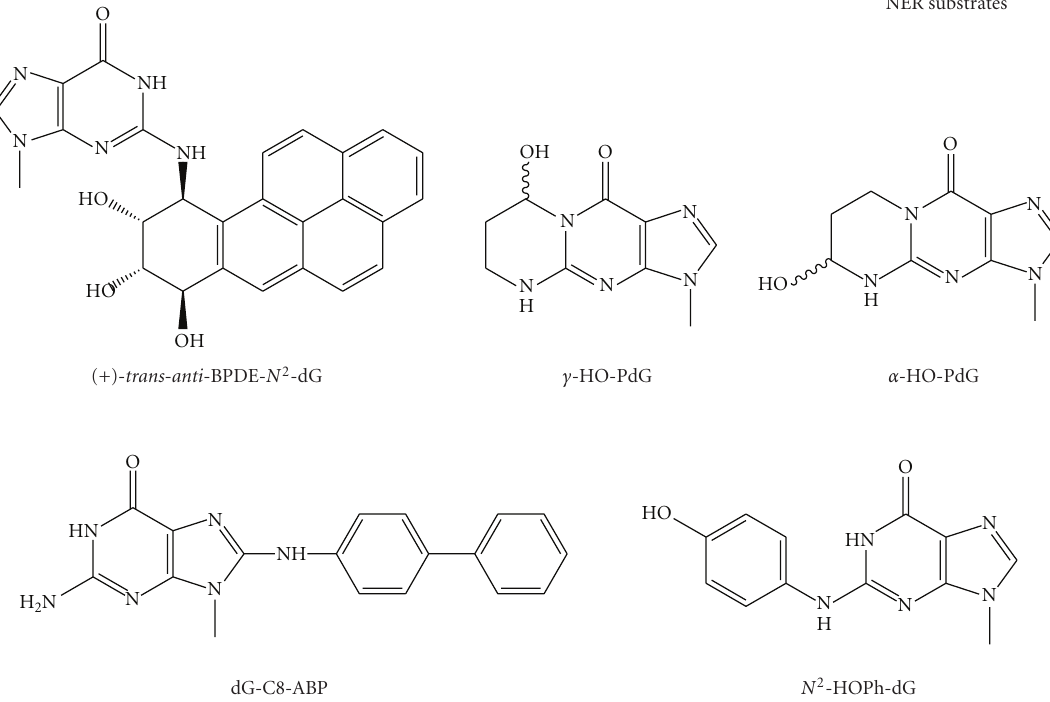
Figure 3: Structures of smoking-induced bulky DNA adducts that are substrates for